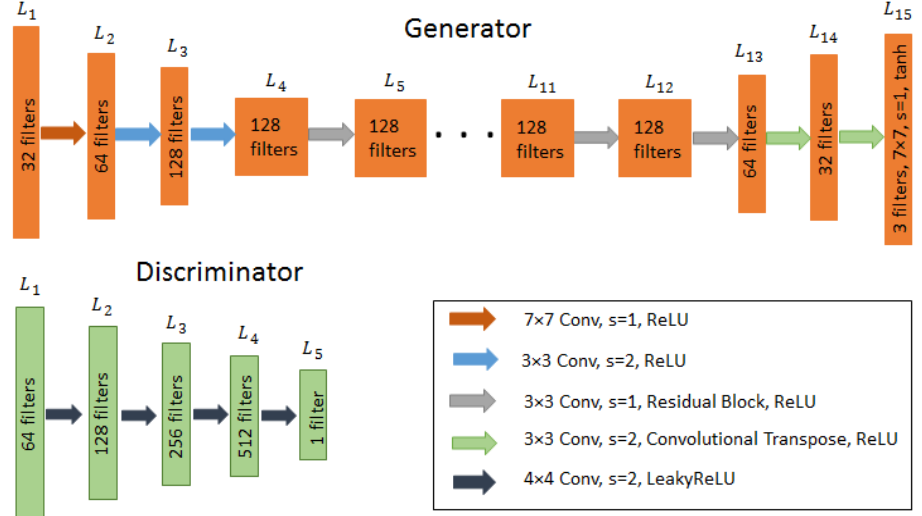
Figure 3. Architecture of the generator and discriminator of unpaired CycleGAN. Conv: 2D Convolutional filter, s: Stride, ReLU: Rectifier linear